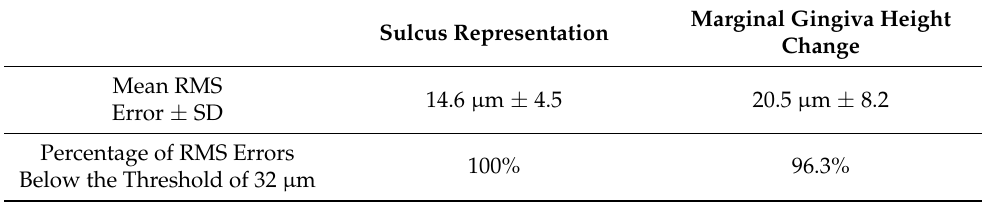
Table 4. Root mean square (RMS) error for the sulcus representation (analysis of all second interven- tion cases) and for the marginal gingiva height change (analysis of all first intervention cases). SD: Standard